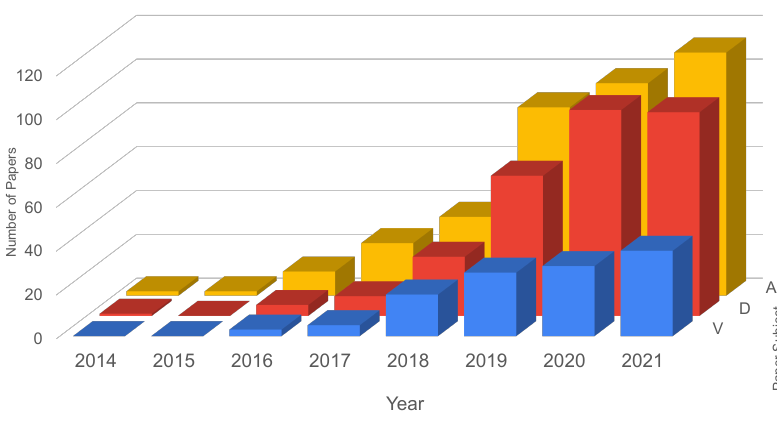
Figure 2. General Review—number of papers focusing on vulnerabilities, attacks and